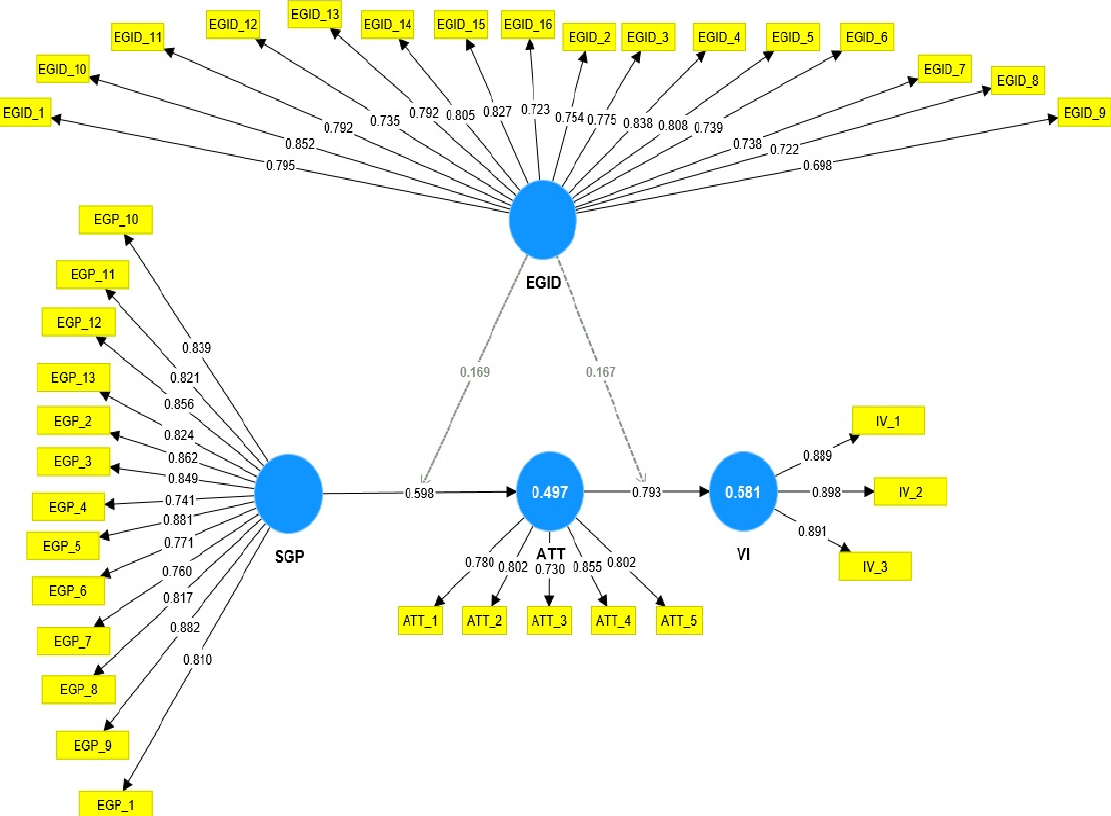
Figure 2. The tested inner and outer model. SGP → Sustainable Gardening Practices; ATT → Consumer Attitudes Towards Green Hotel; VI → Green Hotel Visit Intention; EGID → Environmental Gardening Identity.